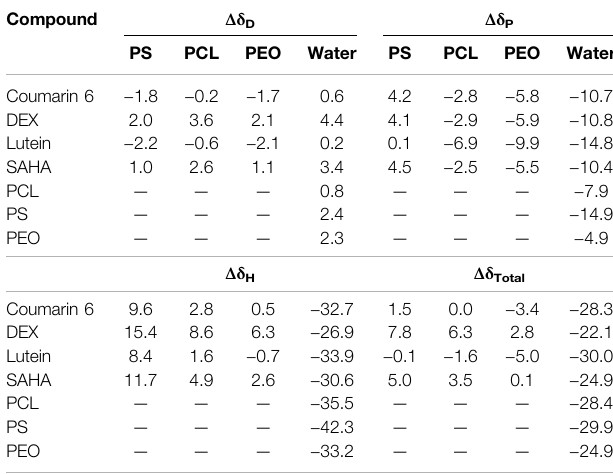
Δδ Δδ Δδ D , P , and H represent the difference in solubility contributions from dispersion, polar, and hydrogen bonding forces of drug to BCP, segment or water. Smaller differences re fl ect greater